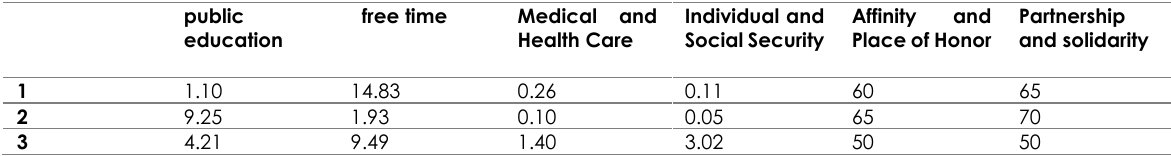
Table 2. Social Data